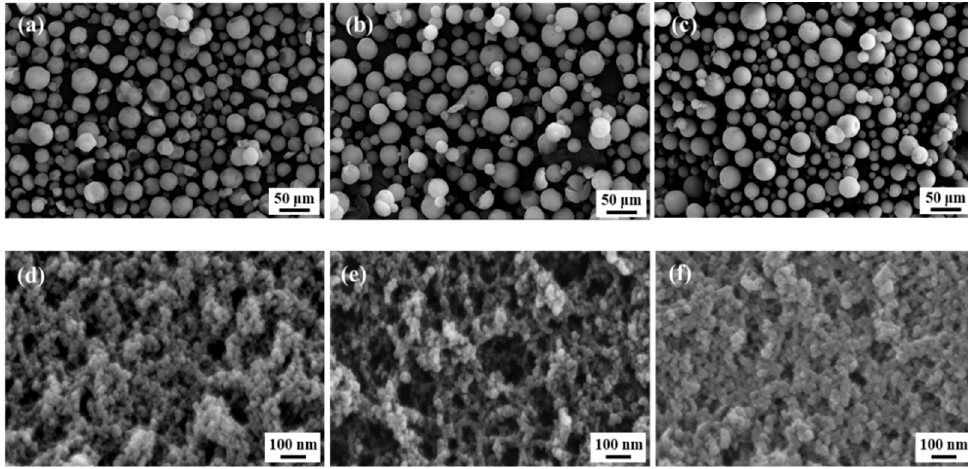
Figure 4. SEM images of silica aerogel powders prepared from ( a , d ) 5.7%; ( b , e ) 6.6%; ( c , f ) 8.7% water glass solutions.